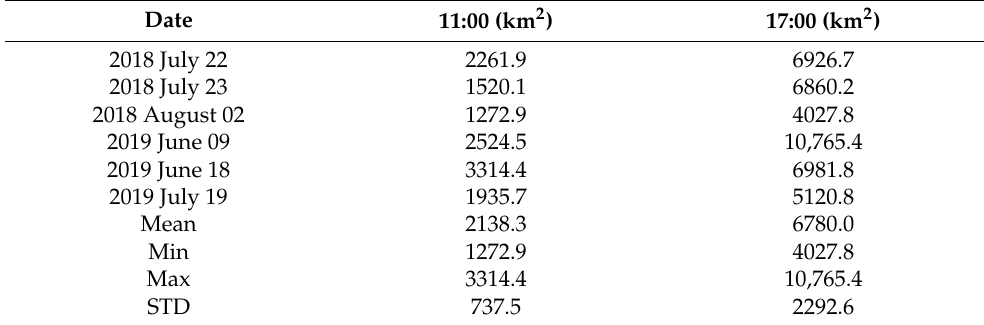
Table 3. The area (km 2 ) of sea breeze penetration from the coast of the southeast Baltic Sea to the mainland of western Lithuania at the time of clear formation (11:00 h) and maximum spread (17:00 h) of the sea